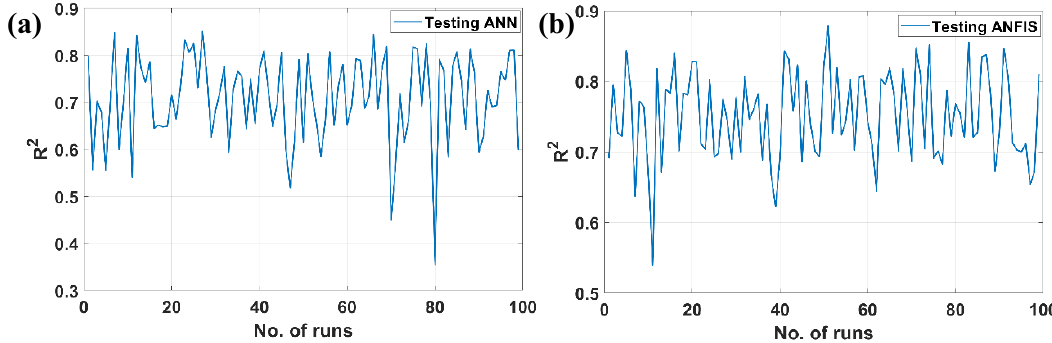
Figure 5. Error distribution ( R 2 ) of different models for 100 runs: ( a ) testing ANN; ( b ) testing ANFIS.